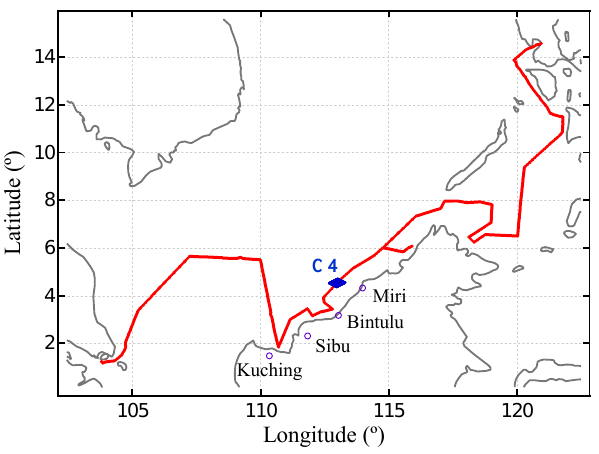
Figure 4. Route of the RV Sonne during SHIVA field campaign (red line) and the position (C4) of the tracer release: PMCP was released on the deck of Sonne from 2:24 to 3:03 UTC on 21 November 2011.